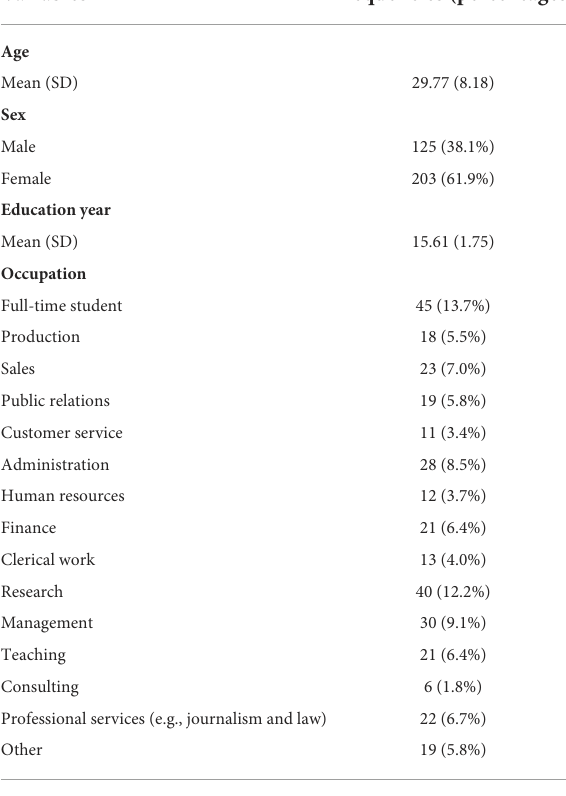
TABLE 1 Demographic characteristics ( N =